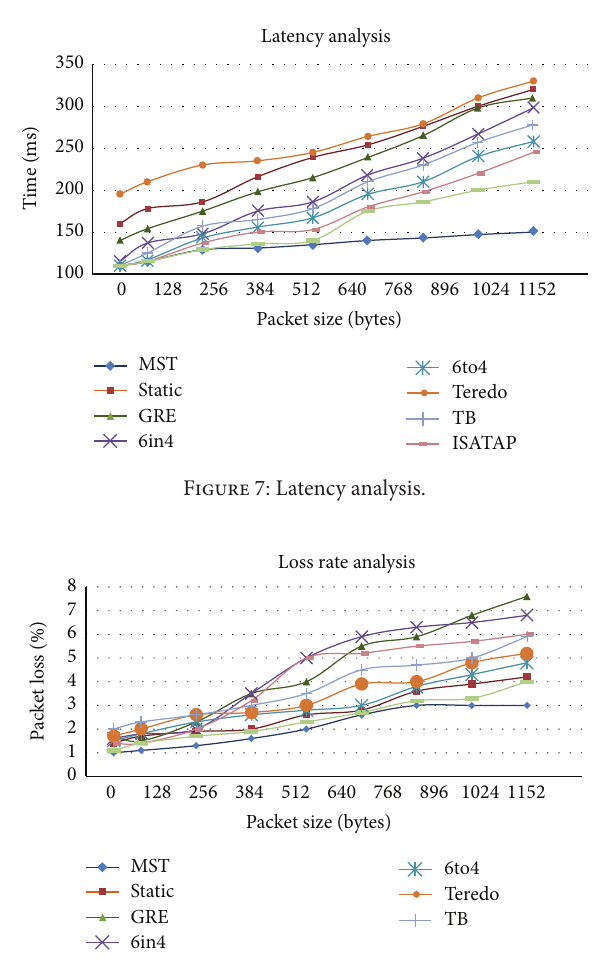
Figure 8: Loss rate